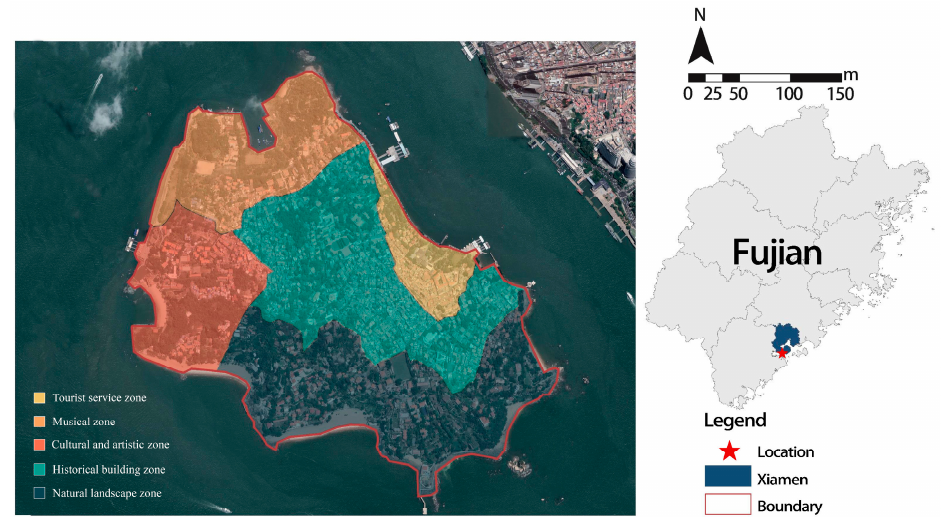
Figure 1. Aerial photo of Kulangsu scenic area (source: elaborated by the authors with Google earth). Table 1. Identified sound sources in Kulangsu.